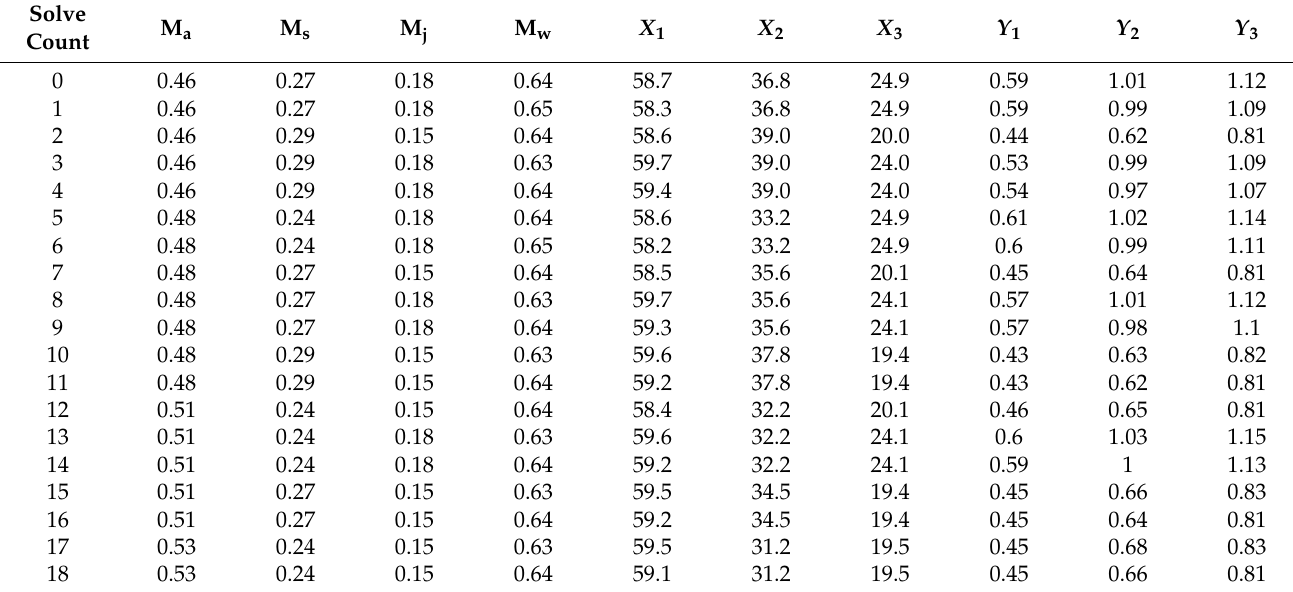
Table 7. Calculation model solving results with C++ program language.